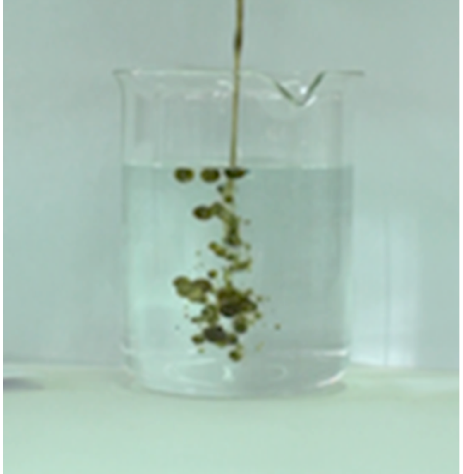
Figure 4. The small surface of oil stains rises to the surface of the water